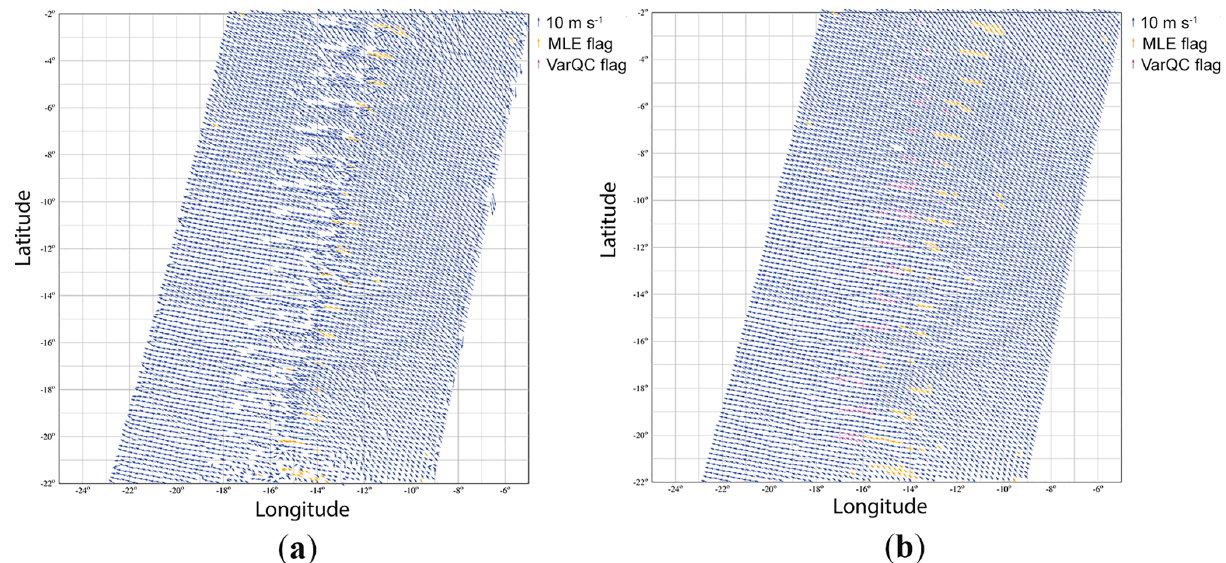
Figure 15. WindRad-retrieved wind field. (a) First rank solution. (b) 2DVAR result. The orange flags are artificial QC points and may be ignored.